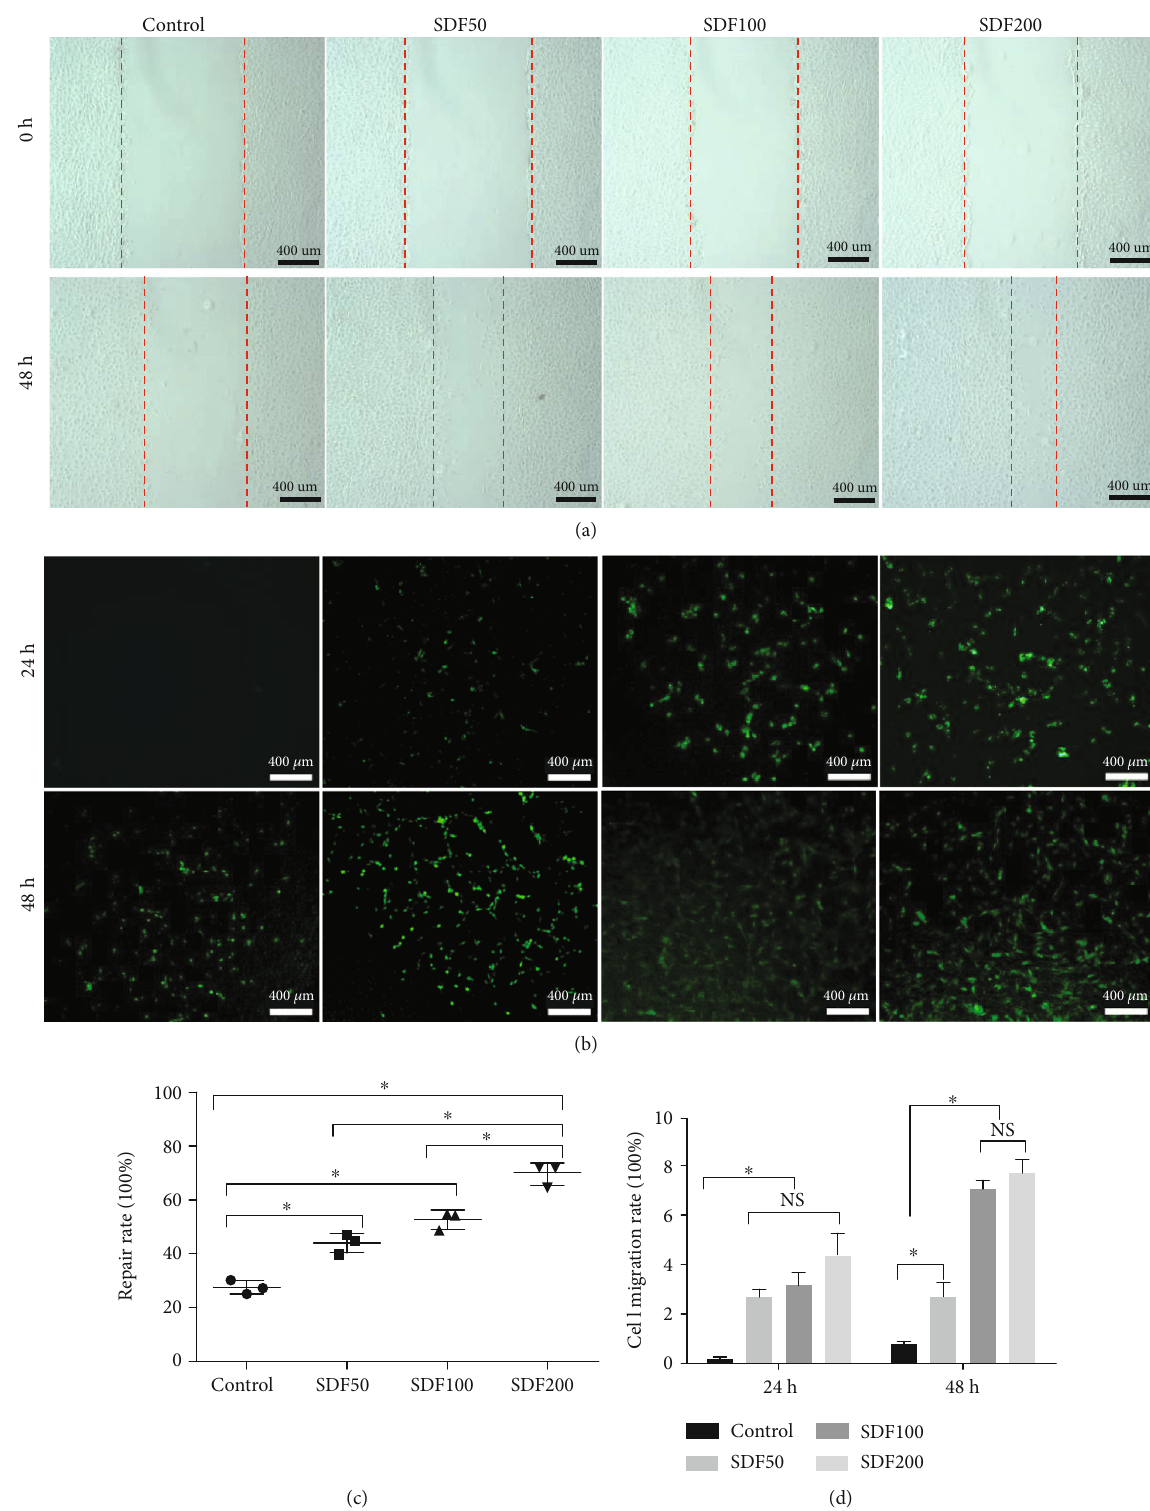
Figure 3: Two-dimensional migration assay of MSCs on the four groups of SDF-1 α /OPF/BP composites. (a) Scratching assay of MSCs (light micrographs) and (b) Transwell assay of MSCs ( fl uorescent micrographs stained by calcein AM staining). (c) Scratching assay showed that the wound healing rates of the SDF100 and SDF200 groups were signi fi cantly higher ( ∗ p < 0 : 05 ) than those of the SDF50 and control groups. (d) Transwell assay showed that the migrating rates of the three SDF groups were signi fi cantly higher ( ∗ p < 0 : 05 ) than those of the control group on the fi rst day, and the migrating rates of the SDF100 and SDF200 groups were signi fi cantly higher ( ∗ p < 0 : 05 ) than those of the SDF50 and control groups on the second day. The red line indicates areas without migrating